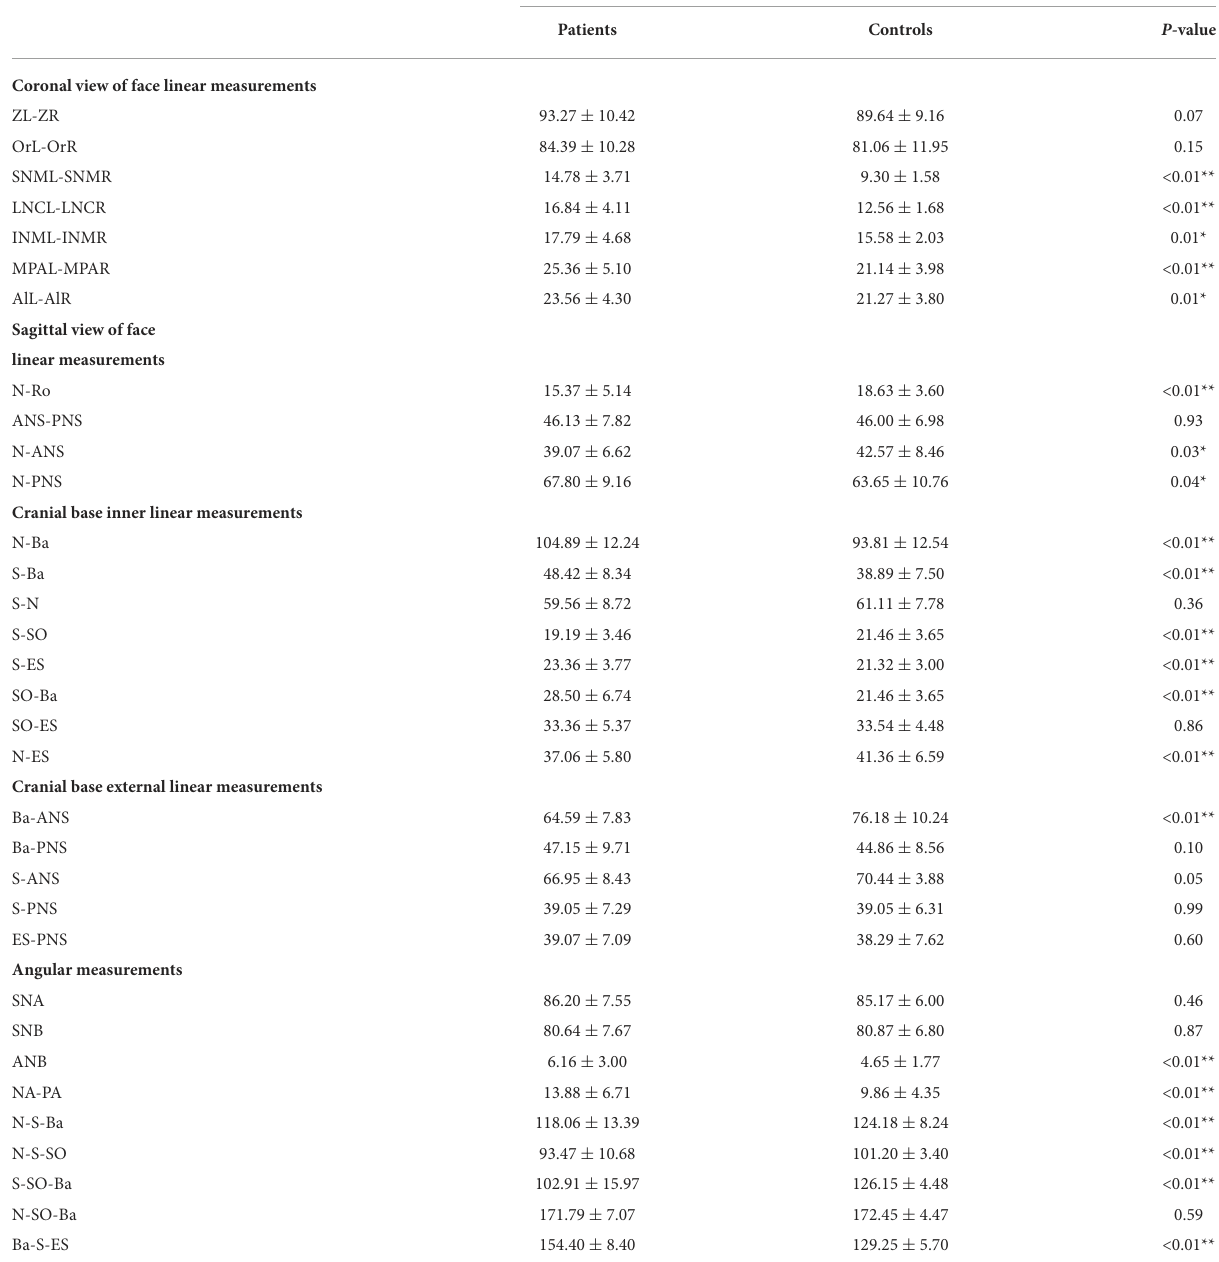
TABLE 2 Cranial base linear and angular measurements in the full age range of Tessier No.0 cleft with a bifid nose compared to